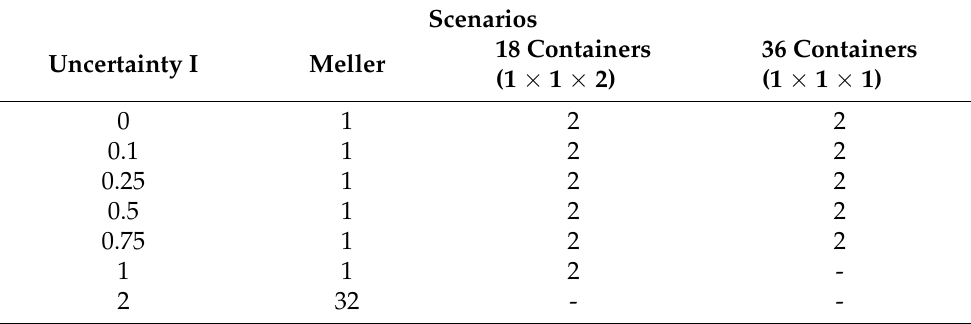
Table 1. Enumeration of the solutions found with a perfect knowledge of the distances d ij between each container. (The “-” in the table are linked either to a timeout (fixed at 5 minutes) or to a number of solutions greater than